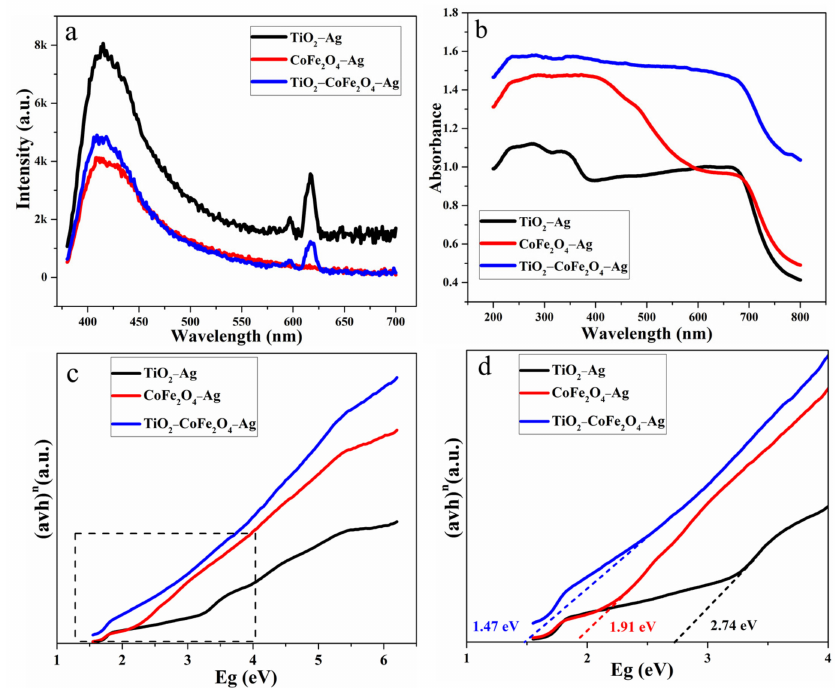
Figure 4. ( a ) Photoluminescence (PL) spectra; ( b ) ultraviolet–visible diffuse reflectance spectra (UV–vis DRS); and ( c , d ) optical band gap of TiO 2 − Ag, CoFe 2 O 4 − Ag, and TiO 2 − CoFe 2 O 4 −